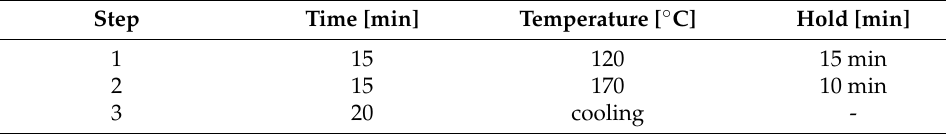
Table 3. Operative conditions for the microwave